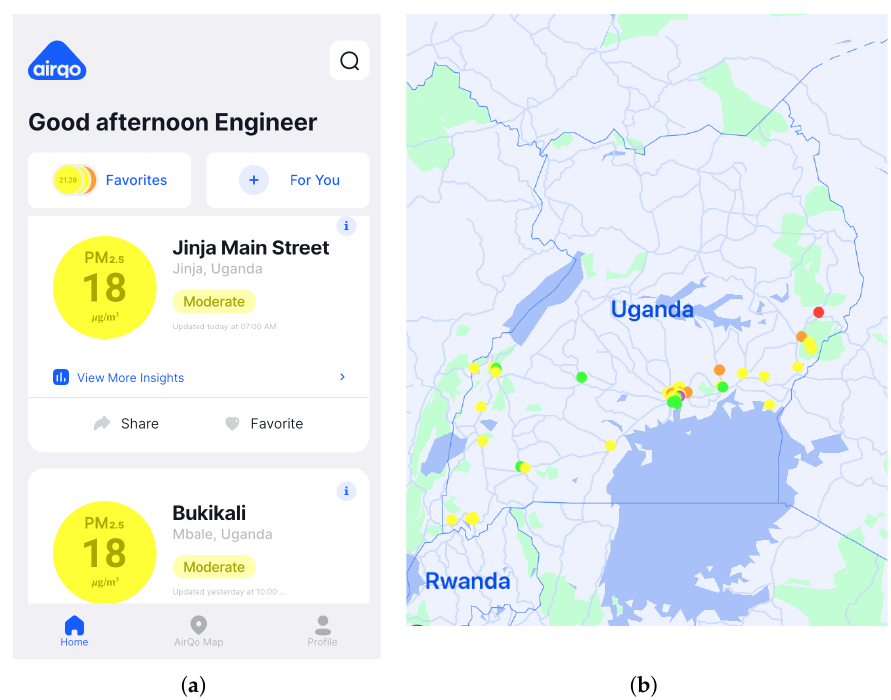
Figure 8. A snapshot of the air quality data insights from the AirQo mobile app. The data is colored with advisory to inform decision making to minimise or reduce exposure to air pollution. Users have an option to favorite specific sites of interest for quick access. ( a ) AirQo mobile app targeting the public users. ( b ) Visualisation of AirQo sites across